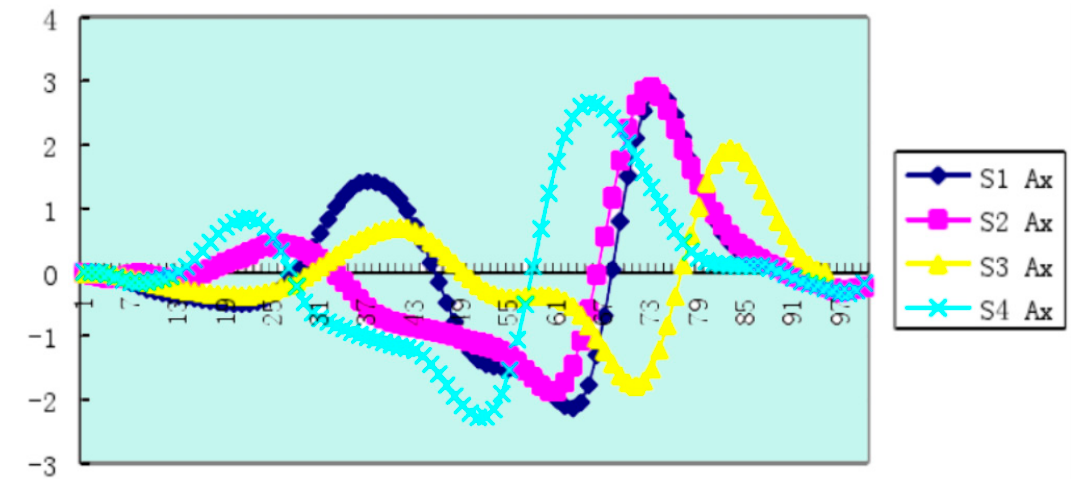
Figure 6. The horizontal speed graph of the center of gravity of the four athletes. The abscissa is the time of a swimming cycle, and the ordinate is in radians per second.